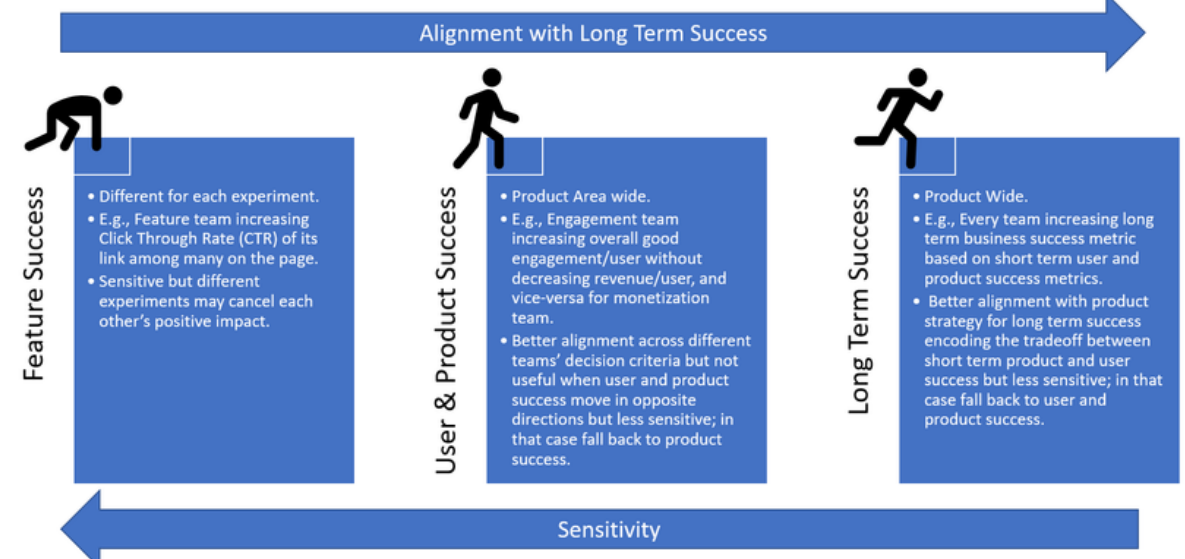
Figure 6. Evolution of the overall evaluation criterion (OEC) metrics as experimentation